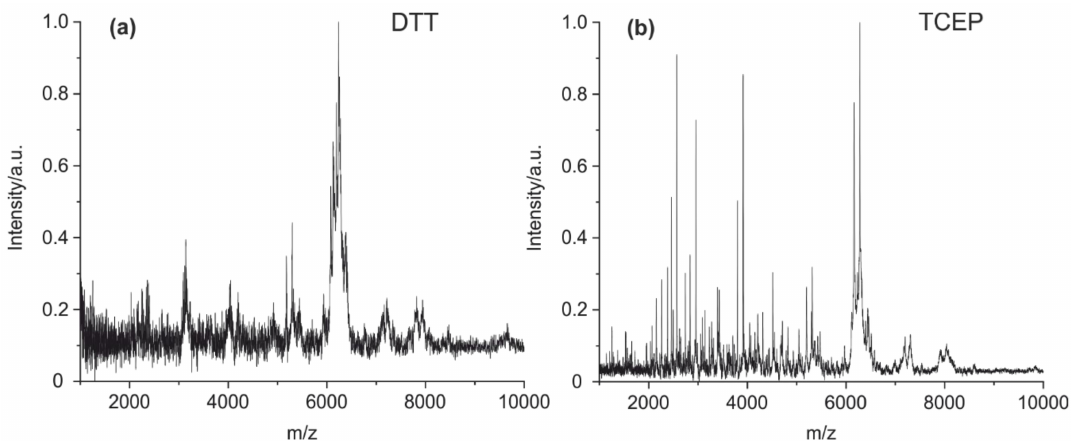
Figure 3. MALDI-TOF MS spectra of ( a ) mouse IgG1 cleaved with DTT as a reductant and ( b ) mouse IgG1 with TCEP as an additive. It is evident that TCEP seems to be the preferred reagent for the cleavage of disulfide bridges.